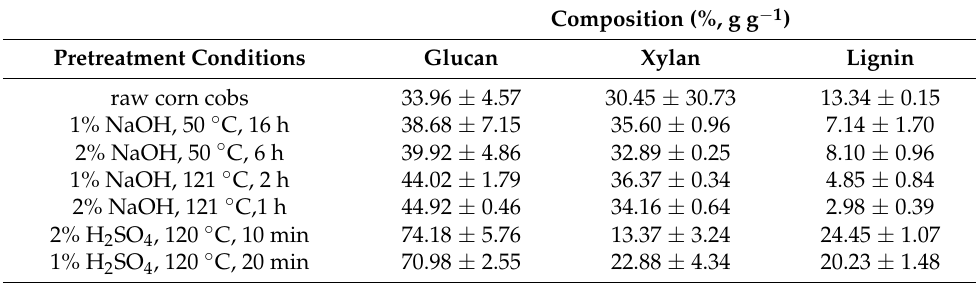
Table 2. Composition of raw and pretreated corn